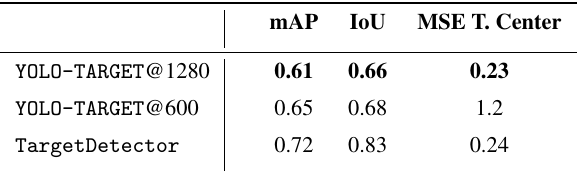
Table 2. Results of comparison new and old